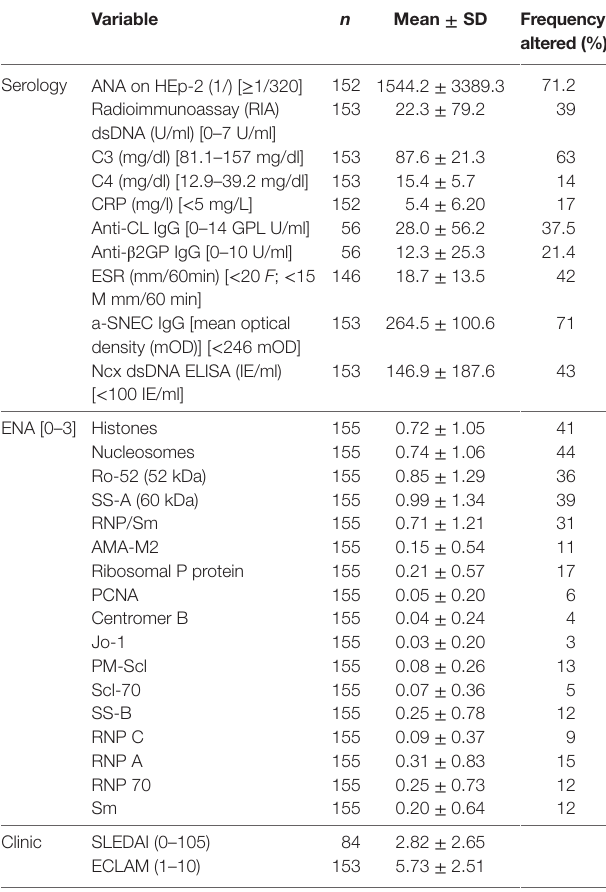
TaBle 2 | Serological and clinical characteristics of the SLE cohort. Variable